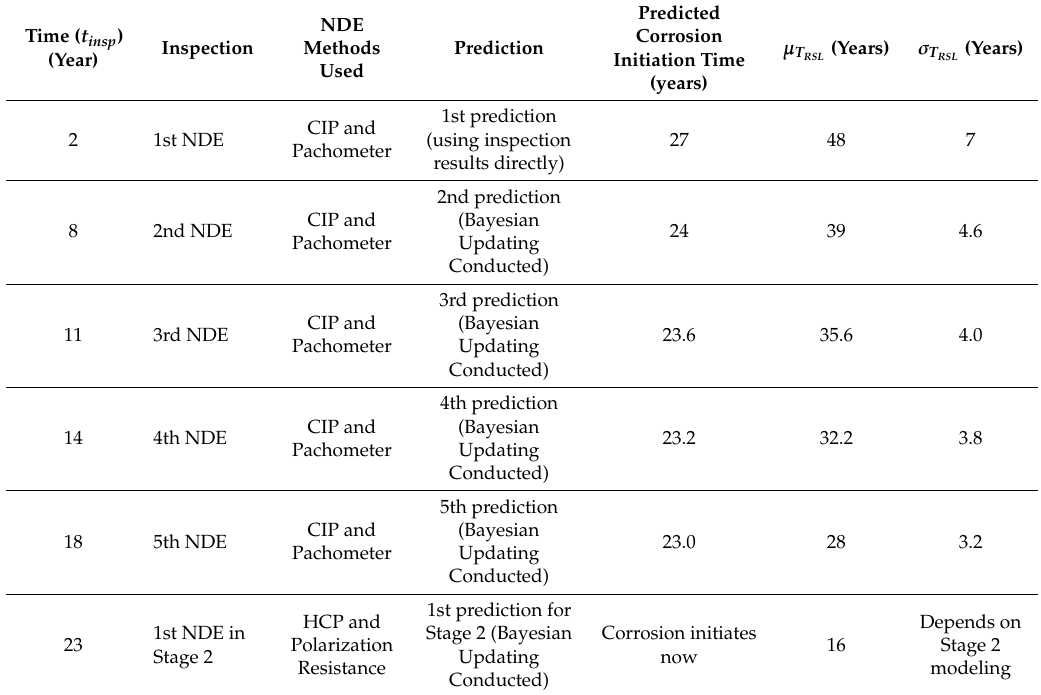
Table 7. Summary of all inspections in Stage 1.